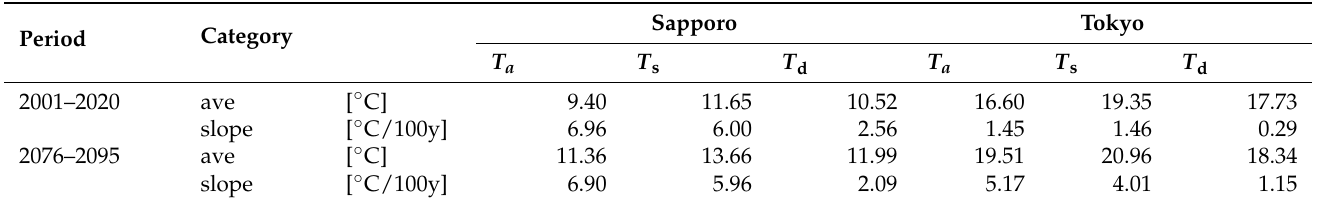
Figure 11. Calculation results of ground temperature at a depth of 2 m, T s , and 50 m, T d , in ( a ) the present and ( b ) the future in Sapporo. Table 2. Summary of soil temperature calculations, T s and T d , at a depth of 2 m and 50 m,